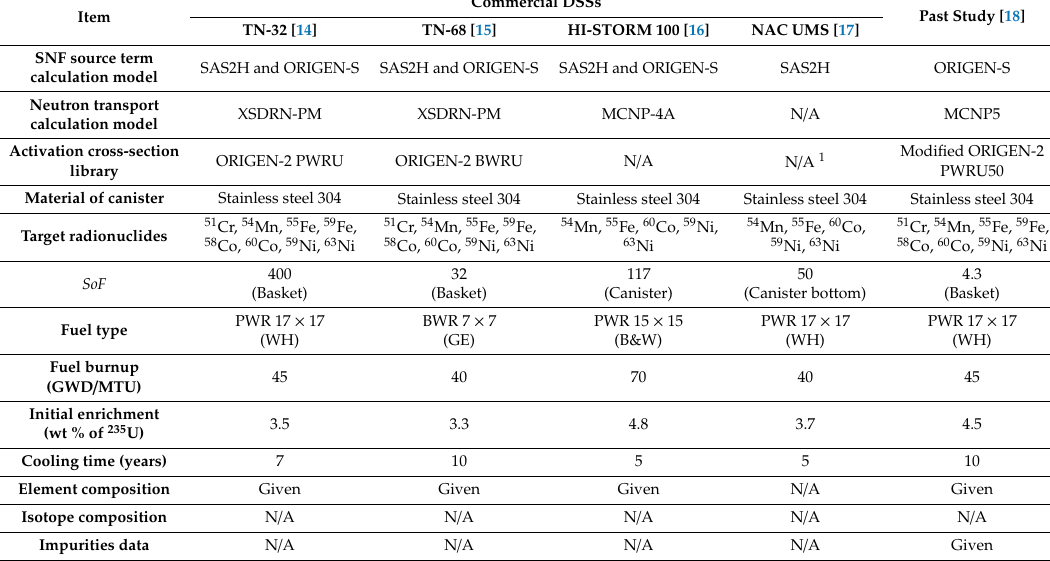
Table 1. Assumptions, conditions, and approaches for neutron activation calculations adopted in four types of commercialized dry storage systems (DSSs) for spent nuclear fuel (SNF) and one relevant